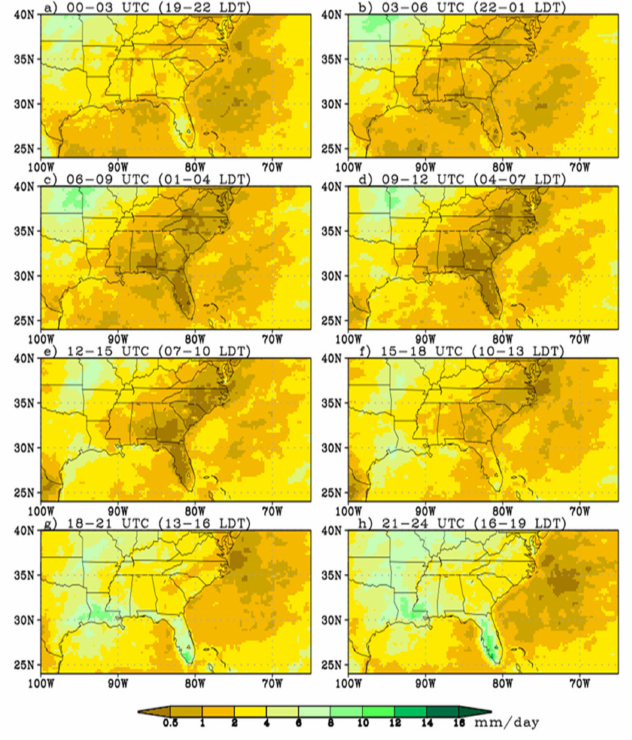
Figure 12. Same as Figure 7, but for